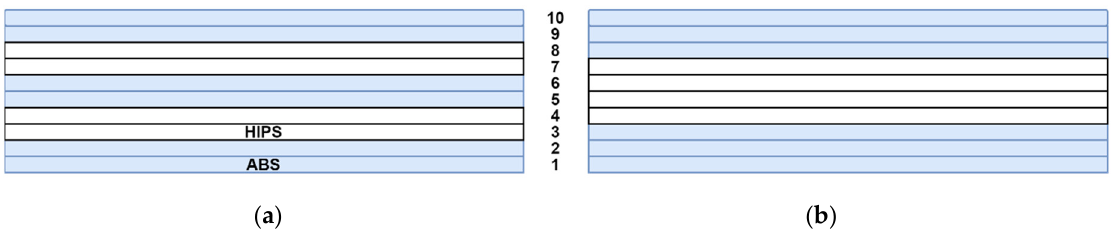
Figure 13. Multi-material combination schematics: ( a ) alternating specimen, ( b ) sandwich specimen.